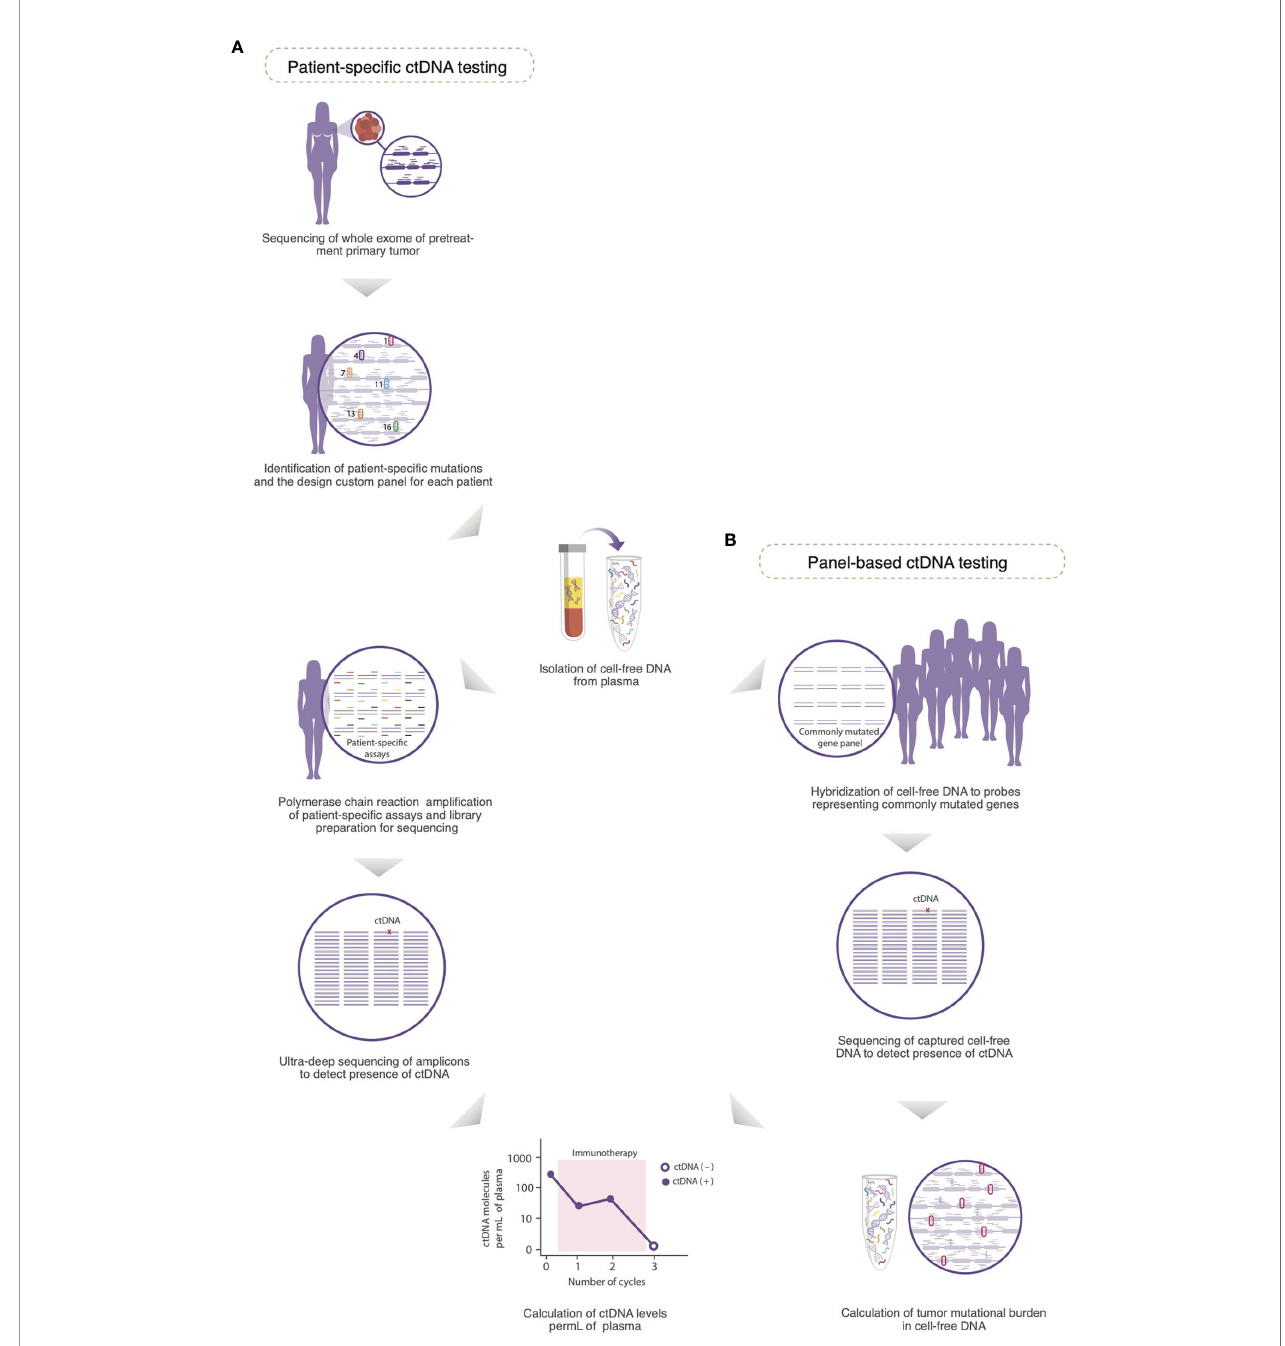
FIGURE 2 | Detection of circulating tumor DNA (ctDNA) in plasma. (A) A customized panel containing multiplexed assays is designed to detect patient-speci fi c mutations in cell-free DNA. The personalized panel is created from a list of mutations detected from whole exome sequencing of the untreated primary tumor. Matched germline DNA is also sequenced to exclude non-somatic mutations due to clonal hematopoiesis of indeterminate potential. Amplicons produced by polymerase chain reaction ampli fi cation of genomic regions that contain the selected mutations are subjected to ultra-deep sequencing to detect the presence of ctDNA. (B) In a panel-based approach, cell-free DNA is hybridized to probes that represent a panel of frequently mutated genes (e.g., PIK3CA and TP53 ), and therefore, the mutational pro fi le of the corresponding solid tumor is not required for testing. The captured cell-free DNA molecules are then subjected to next generation sequencing to detect the presence of ctDNA. Because the panel of genes used for testing is consistent across all samples, and includes highly mutated genes, the tumor mutational burden in cell-free DNA can be calculated. In both approaches for testing of ctDNA, serial plasma can be prospectively collected to monitor the levels of ctDNA as a potential biomarker of response to immunotherapy [Modi fi ed with permissions from